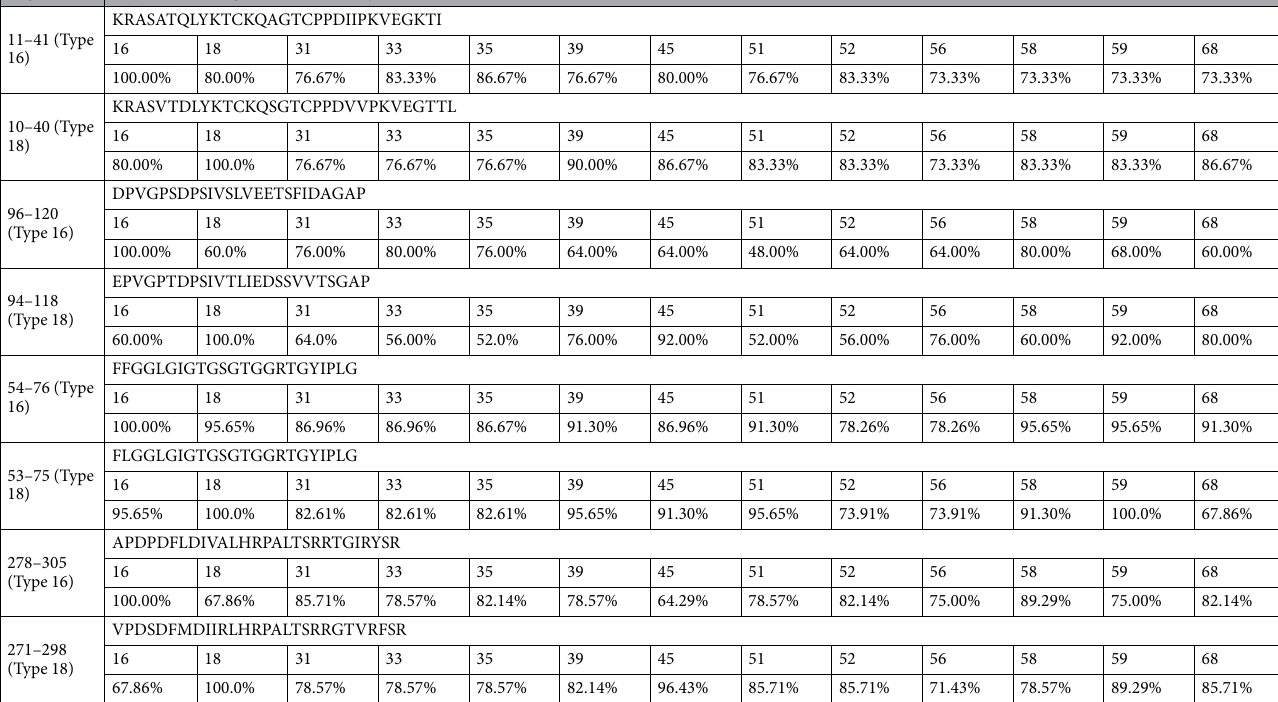
Table 2. Conservancy analysis of high-risk HPV L2